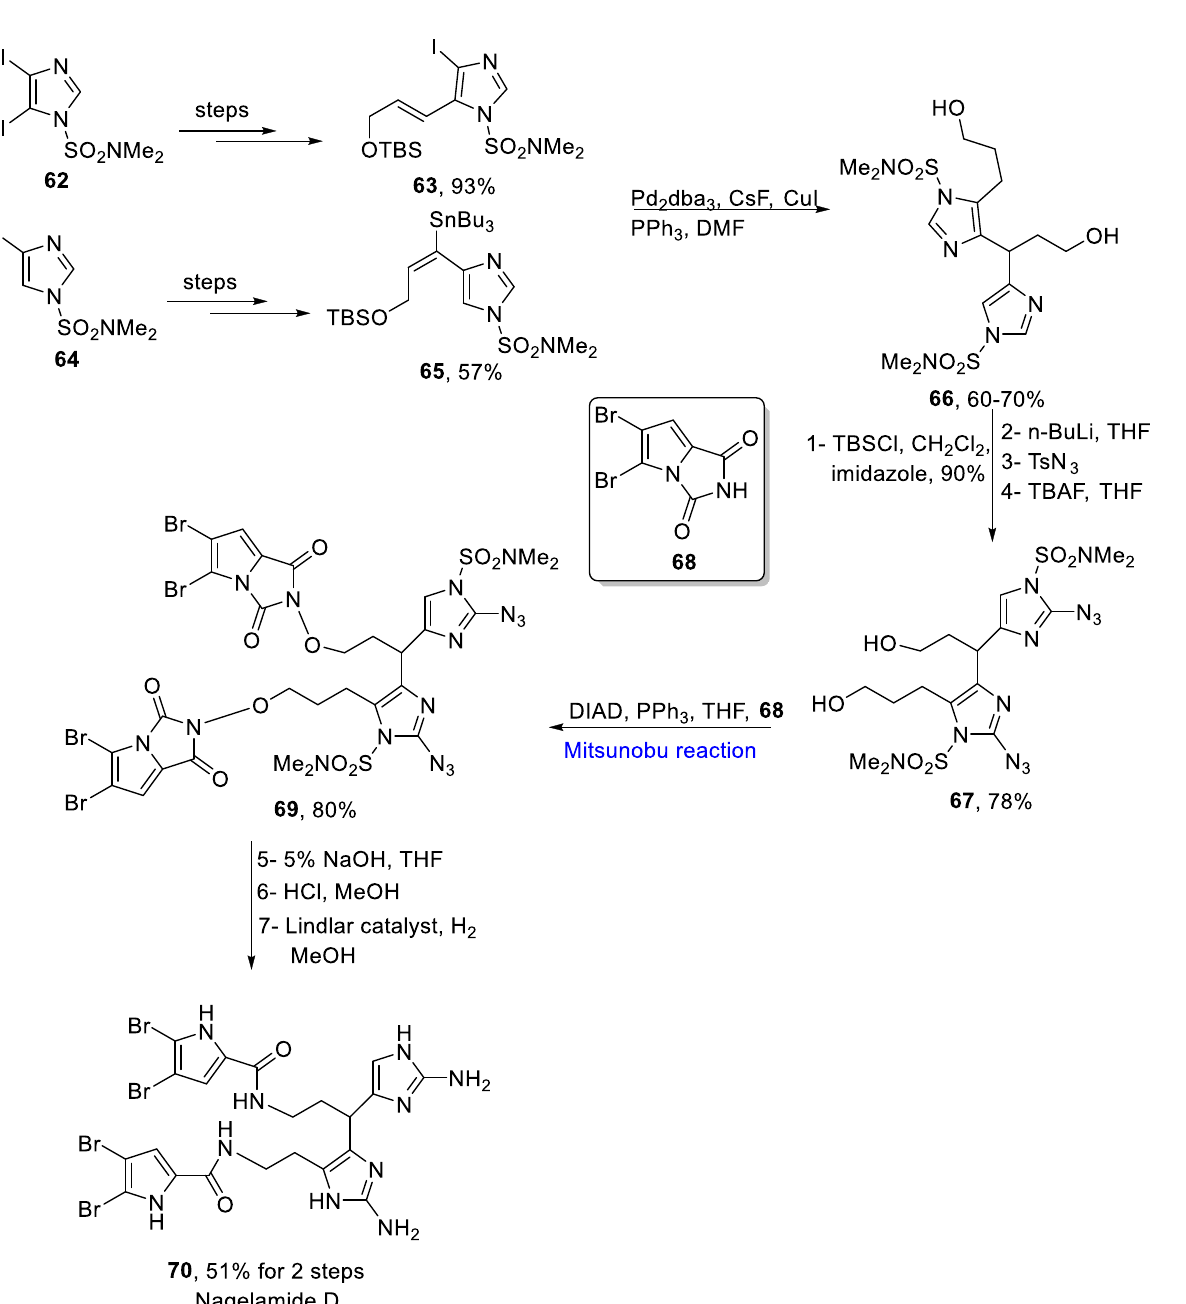
Scheme 10. Total synthesis of nagelamide D 70